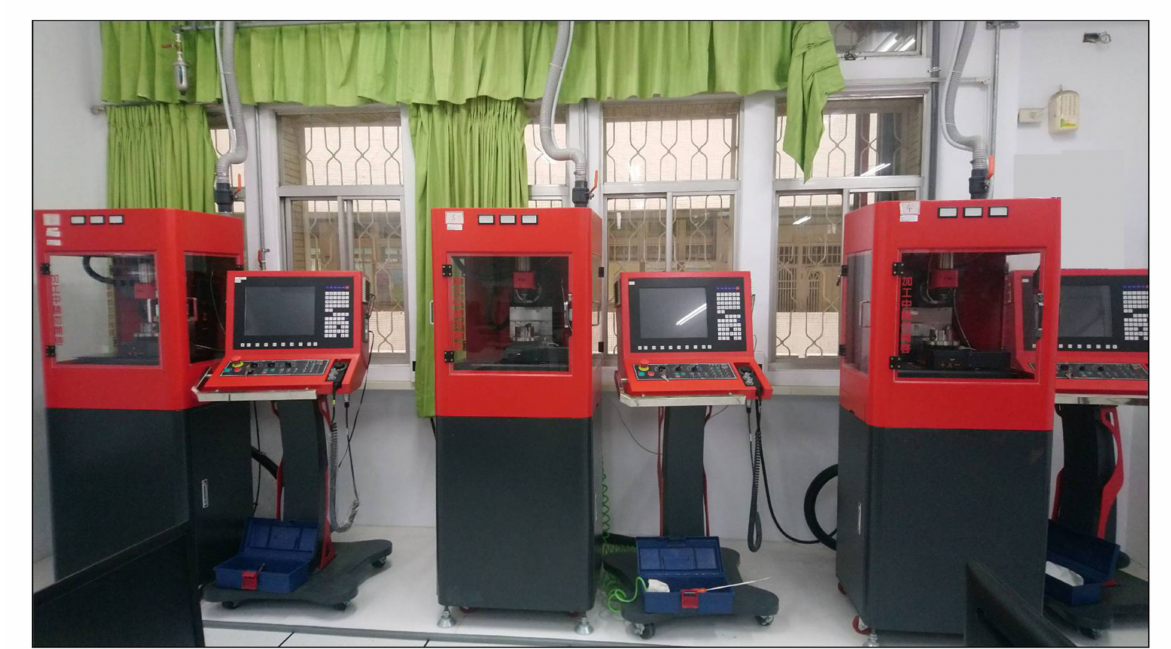
Figure 6. Three miniature five-axis machine tools of the same